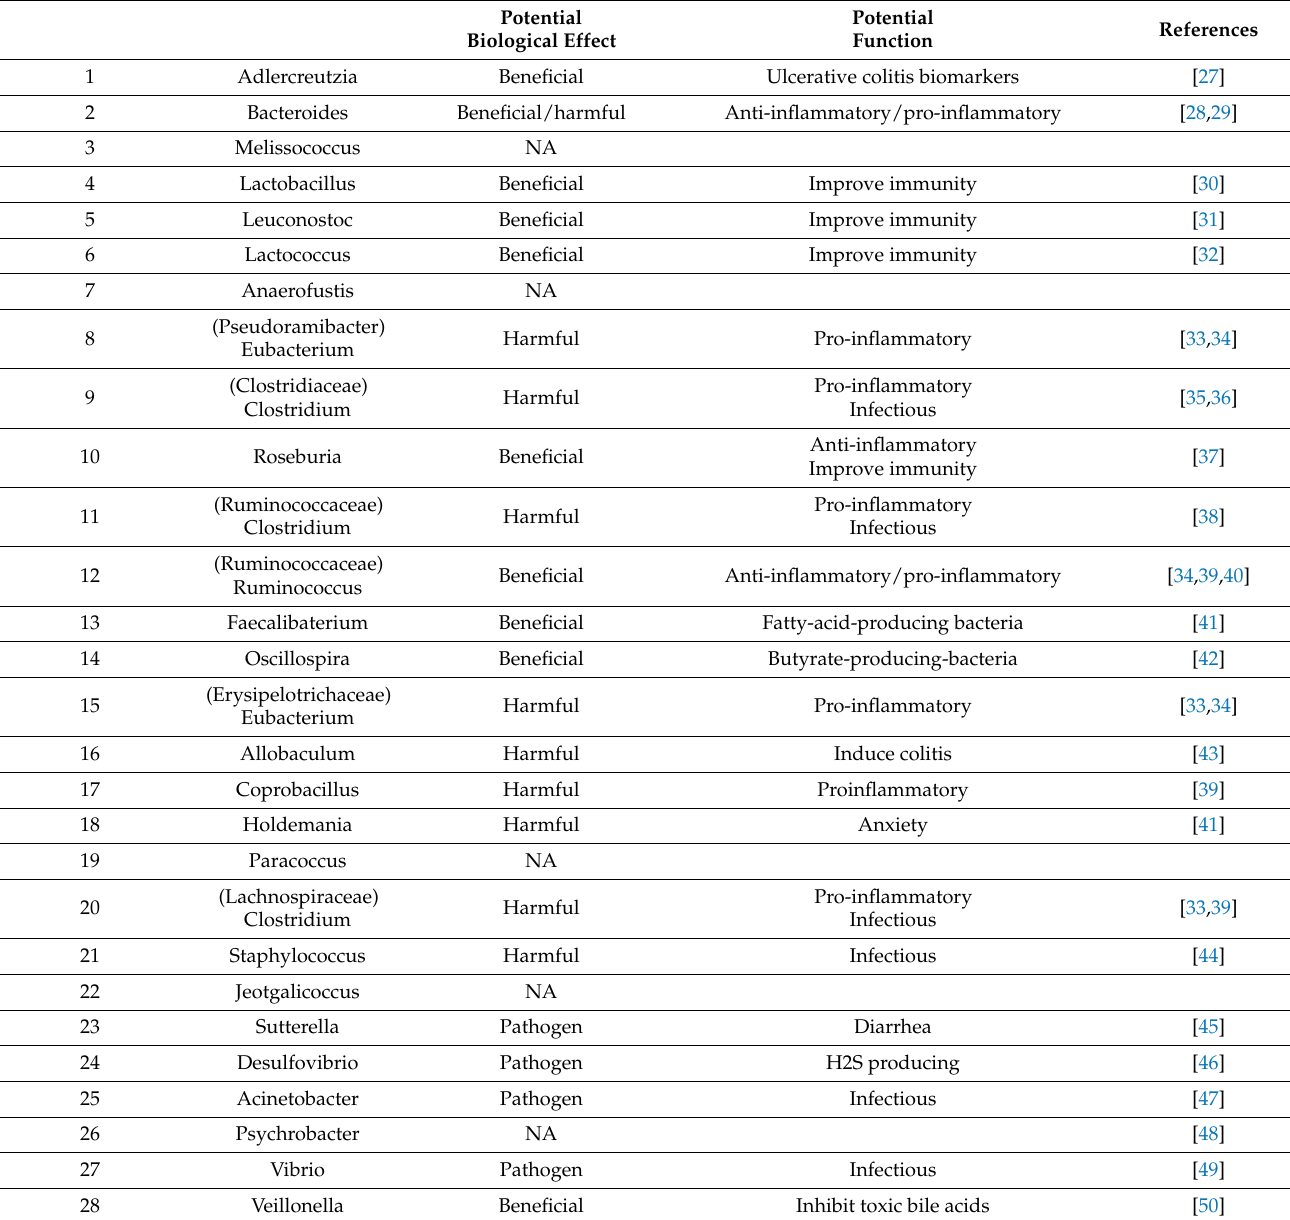
Table 2. Differential taxa and potential biological functions in the